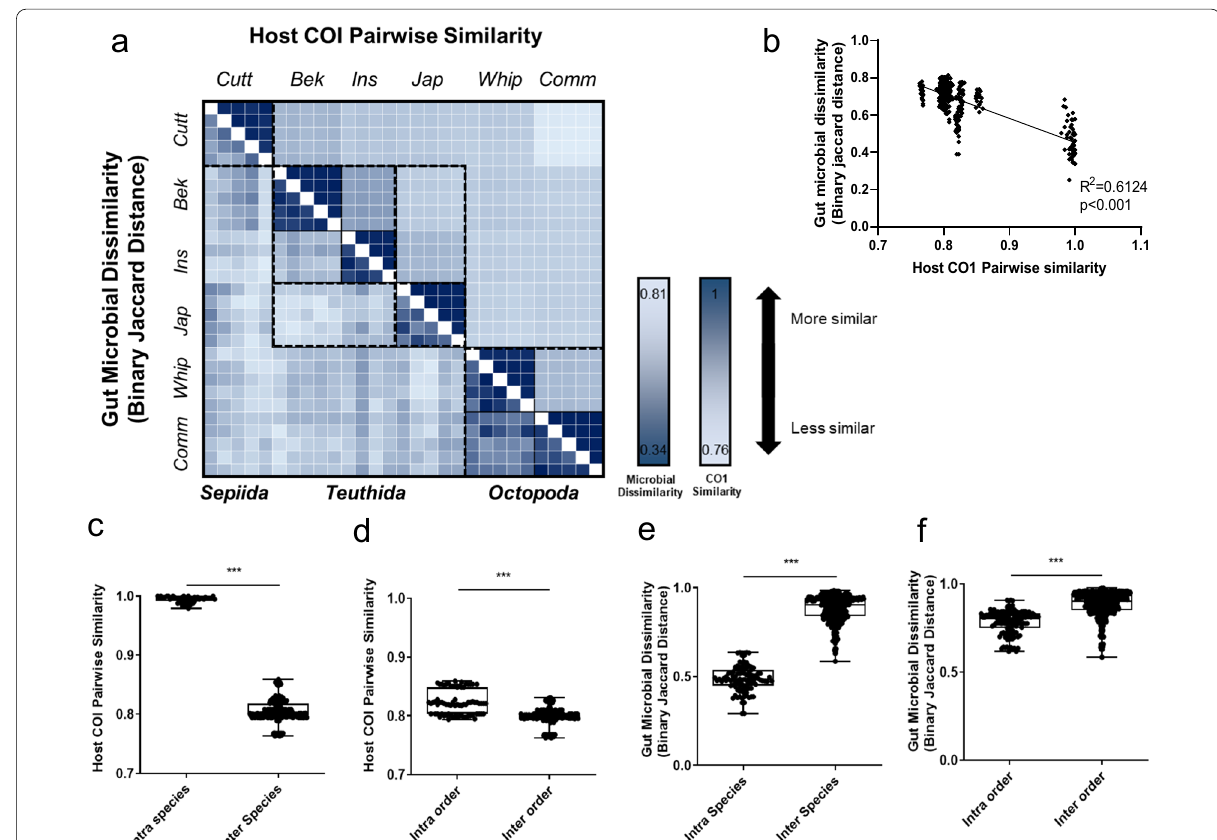
Fig. 2 Association of host similarity and gut microbial dissimilarity. a Heatmap of gut microbial dissimilarity based on binary Jaccard distance metrics (left lower half) and host genetic relatedness based on COI gene similarity (right upper half). The range of colors indicates microbial dissimilarity or host COI gene dissimilarity: from light blue (highest gut microbial dissimilarity or lowest host COI gene dissimilarity) to dark blue (lowest gut microbial dissimilarity or highest host COI gene dissimilarity). b Linear regression analysis with the slope of the regression line for host COI gene similarity versus microbial dissimilarity. c , d Comparisons of intra‑ and inter‑specific ( c ) and intra‑ and inter‑order ( d ) host COI similarities. e – f Comparisons of intra‑ and inter‑specific ( e ) and intra‑ and inter‑order ( f ) microbial variation based on binary Jaccard distances. Asterisks indicate significant differences according to two‑tailed Mann–Whitney U tests. * p < 0.05, ** p < 0.01; *** p < 0.001. Abbreviations: Cutt, cuttlefish; Bek, beka squid; Ins, Inshore squid; Jap, Japanese flying squid; Whip, whiparm squid; Comm, common